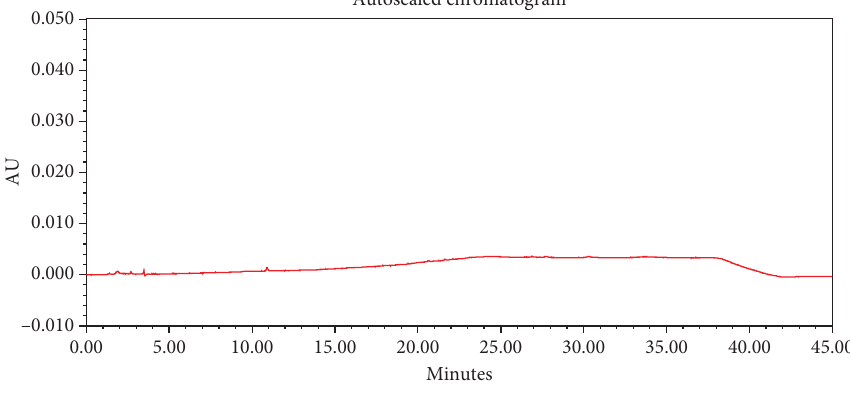
Figure 2: Chromatogram of the blank sample solution.